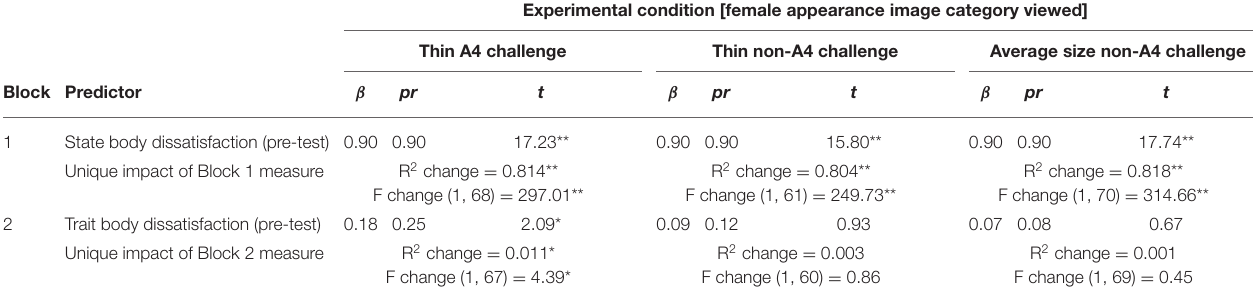
TABLE 5 | The impact of trait body dissatisfaction on changes in state body dissatisfaction within conditions of female image exposure experiment ( N =